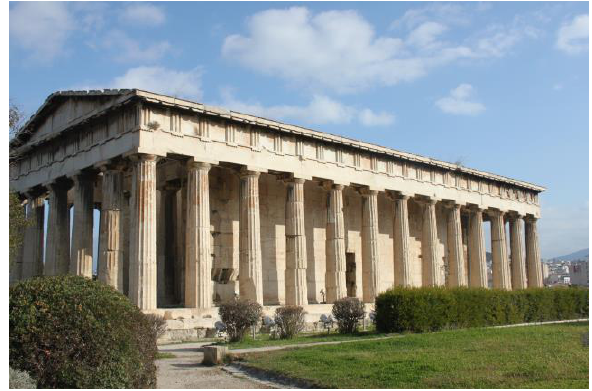
Figure 8. The temple of Hephaestus in the Ancient Athens Agora (image by